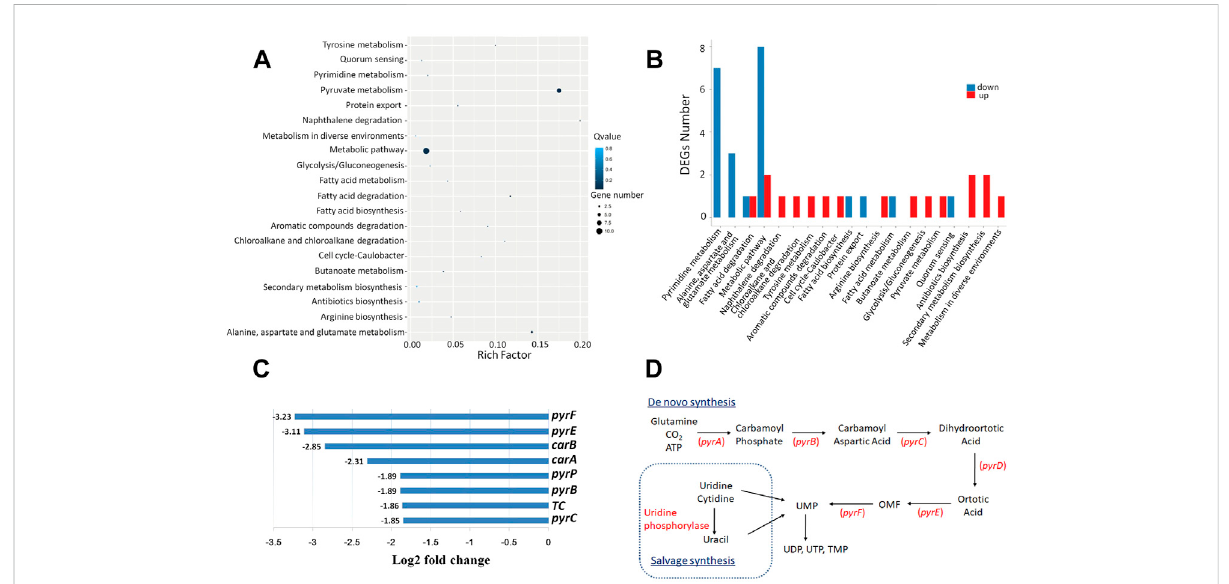
LP4C downregulates the expression of genes involved in the pyrimidine de novo synthesis pathway of MRSA. Top 20 statistics of pathway enrichment after compound LP4C (100 μ g/ml) treatment to MRSA USA 300 (A) . The DEGs number of most enriched pathway of MRSA USA 300 treated by compound LP4C (B) . The log2 fold change value of top down-regulated expressed genes (C) . The illustration of de novo salvage bacterial pyrimidine synthesis pathway (D) .